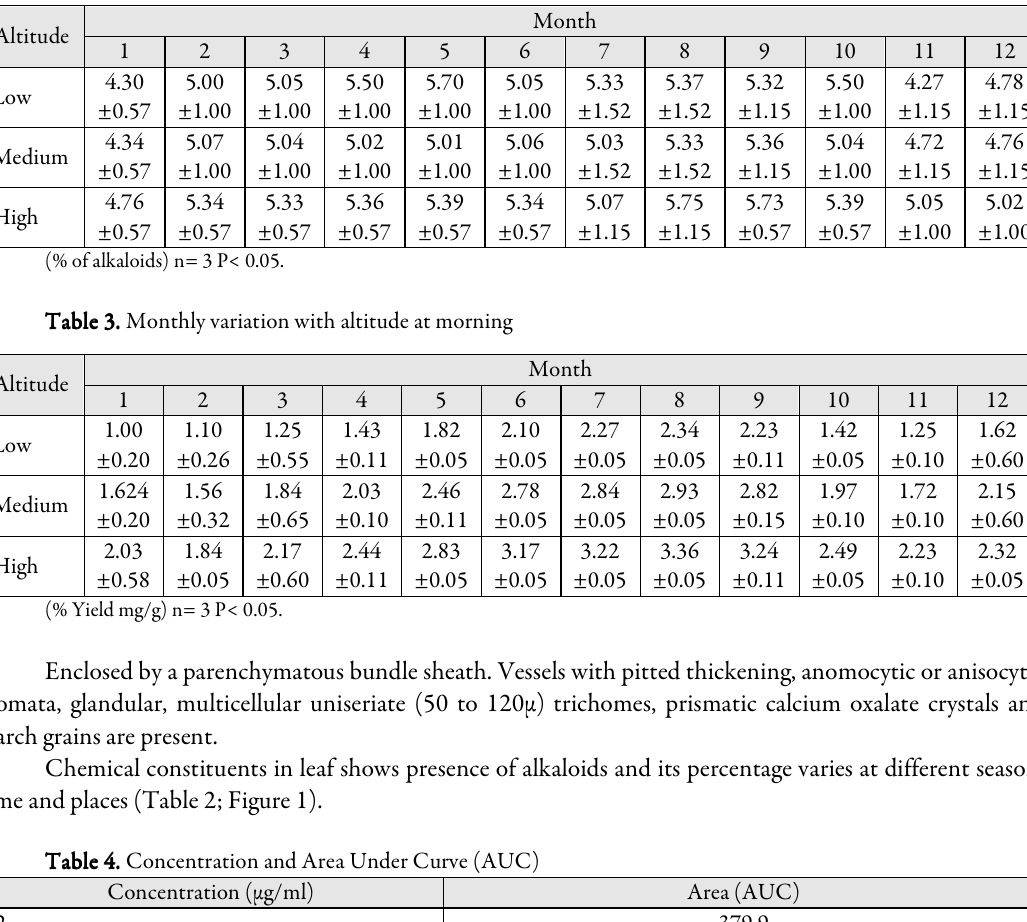
Table 2. Monthly variation with high altitude at morning